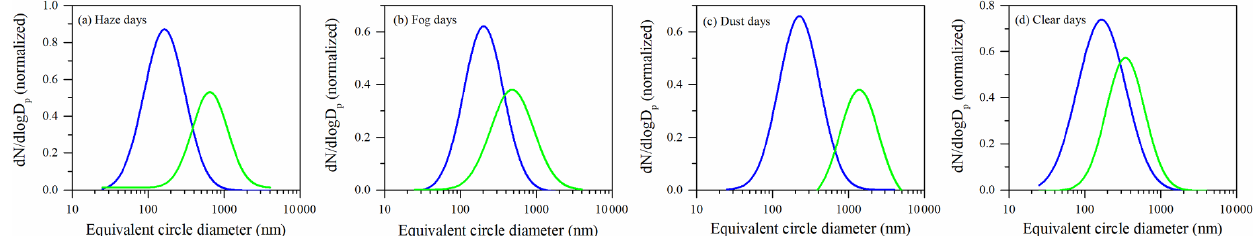
Figure 6. Size distributions of Fe-rich (blue line) and S-Fe (green line) particles under haze (a) , fog (b) , dust (c) , and clear (d) conditions. The size of the S-Fe particles represents the dry state of individual particles on the substrate. The distribution pattern is normalized.